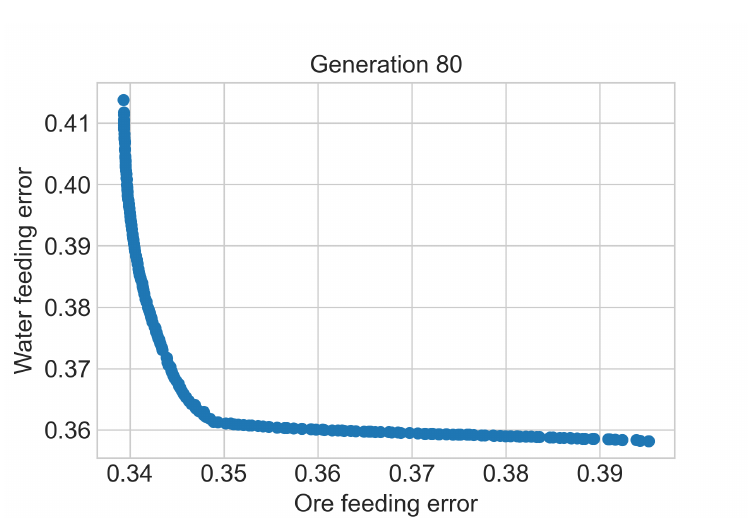
Figure 6. Simulation diagram of the 80th generation.